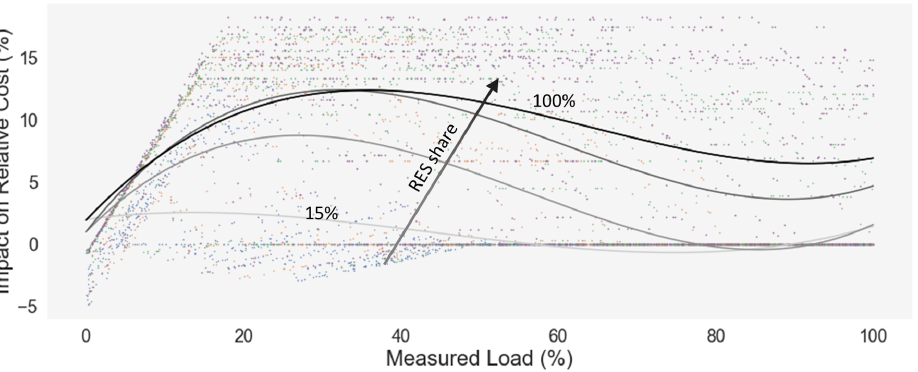
Figure 12. The impact of Dummy Charging on the total cost. It presents the simulations of numerous scenarios considering various environmental conditions and load profiles, for different level of load passing through control reference point (hybrid inverter) in case of dummy charging (represented by the points in the background), and the second-order interpolation of the obtained results in terms of relative cost versus no-battery case.